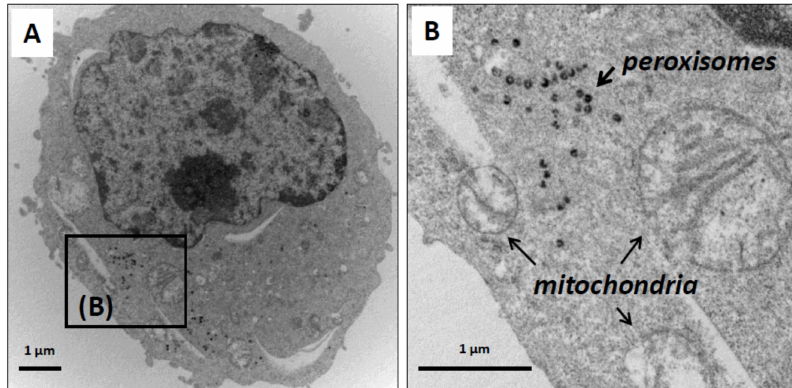
Figure 4. Visualisation of mitochondria and peroxisomes in untreated N2a cells by transmission electron microscopy. Murine neuronal N2a cells were previously cultured for 24 h in conventional cultured medium; the cells were further cultured for 48 h in medium without FBS. The preparations, which were contrasted with uranyl acetate and lead citrate, were also stained with DAB to visualize the peroxisomes. In untreated N2a cells, isolated peroxisomes were rarely detected in the cytoplasm whereas clusters of peroxisomes were often observed ( A ) in regions where several mitochondria were also present. The diameters of the peroxisomes were in the range of 0.1 µ m ( B ).